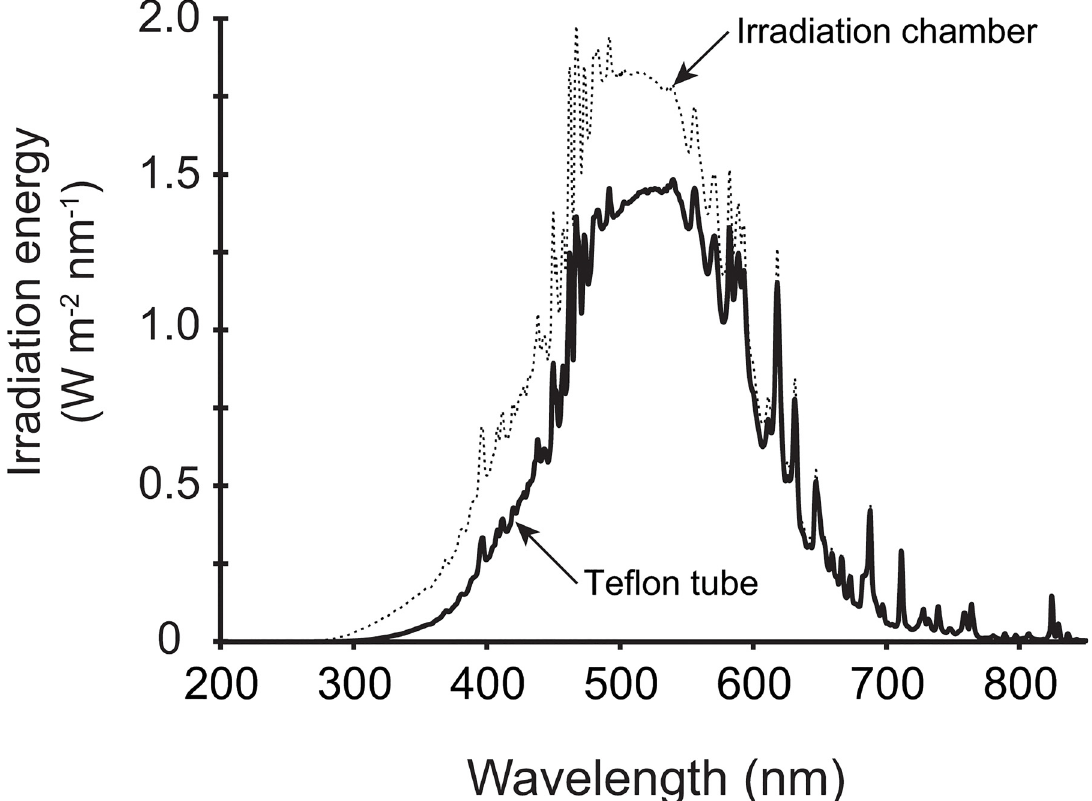
Fig 1. Spectral distribution of irradiation at intensity 700 W m -2 inside the irradiation chamber and inside the Teflon tube.